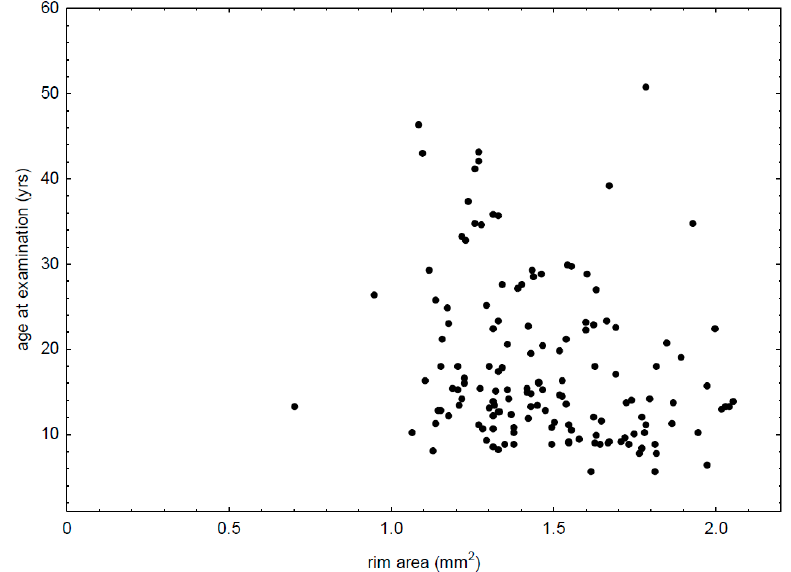
Figure 1. Correlation between rim area and age at examination in patients with type 1 diabetes (R = − 0.28, p = 0.0007).